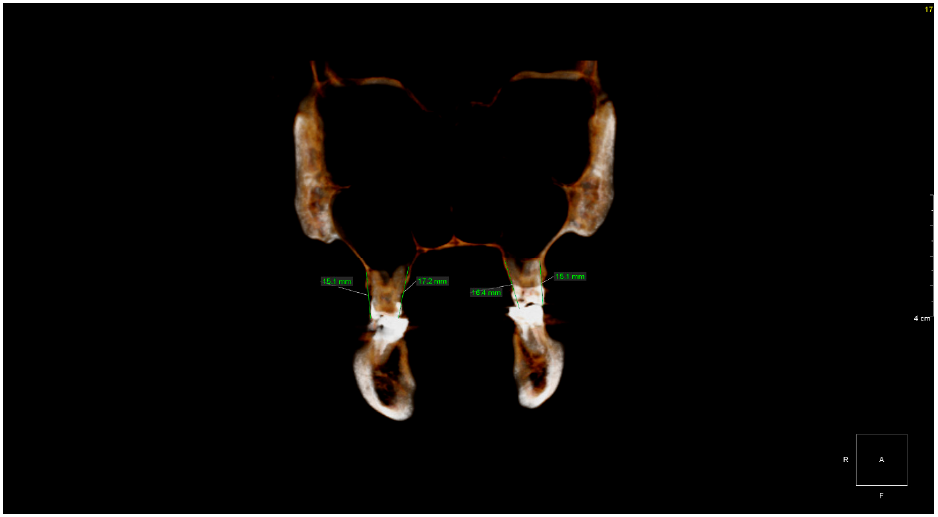
Figure 4. Patient 2. Vertical dimensions of upper first permanent molars (16 and 26)—Coronal volumetric reconstruction from CBCT.